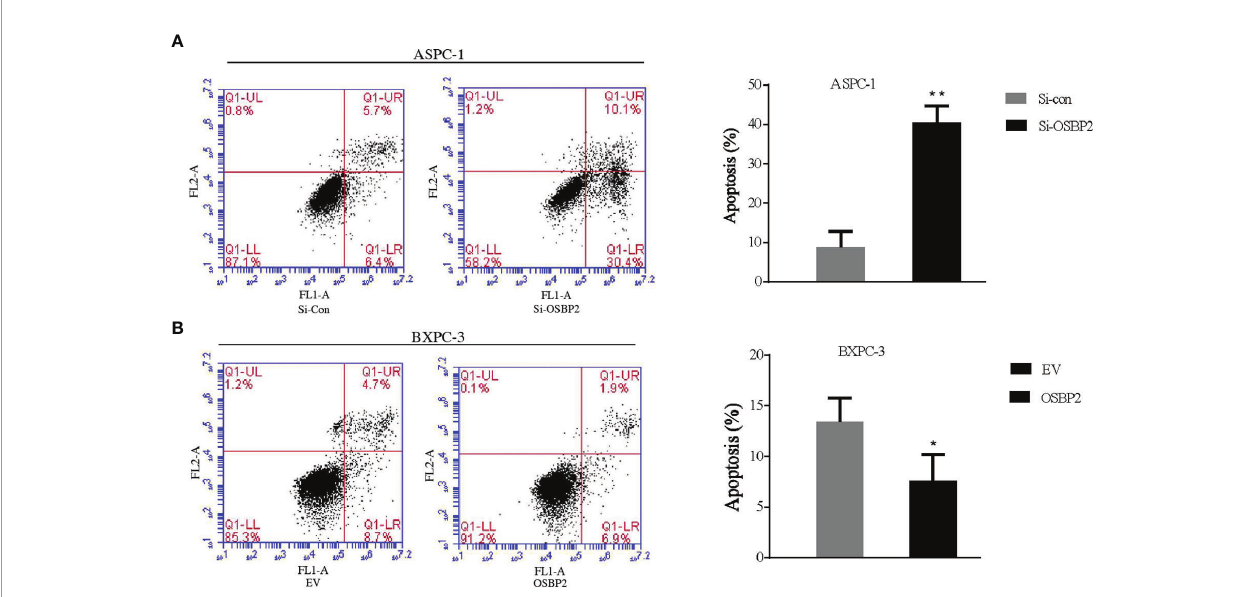
FIGURE 3 | Effect of OSBP2 on PDAC cell apoptosis. (A) Low OSBP2 expression increased tumor cell apoptosis in the ASPC-1 cell line. (B) Overexpression of OSBP2 decreased tumor cell apoptosis in the BXPC-3 cell line. OSBP2, oxysterol-binding protein 2; PDAC, pancreatic ductal adenocarcinoma; Si-OSBP2, siRNA